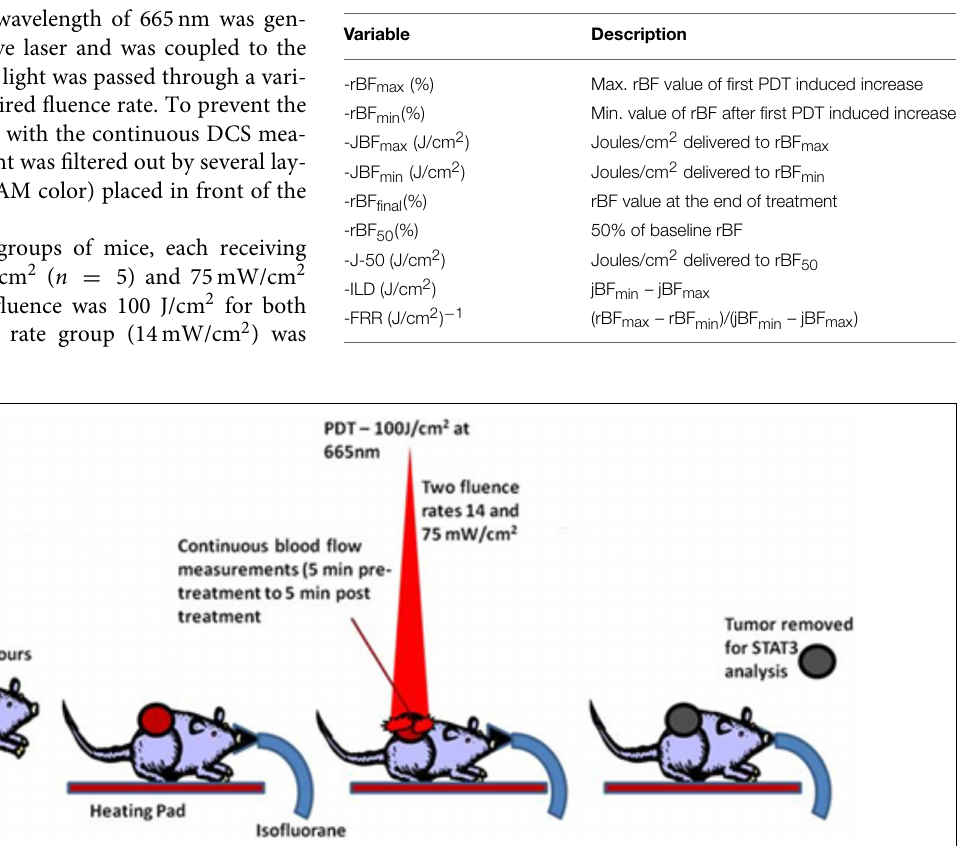
FIGURE 2 | Schematic of preclinical PDT highlighting the optical measurement times in relation to the HPPH injection and light delivery.